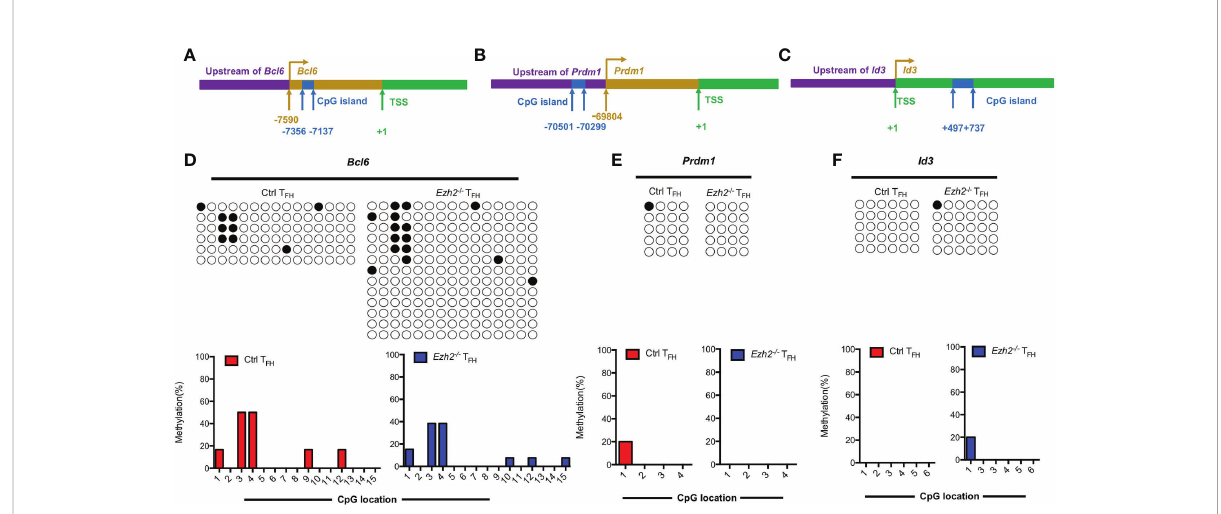
FIGURE 4 EZH2 displays inability to affect the methylation status at other gene loci. Genomic DNA was extracted from sorted T FH cells derived from control and Ezh2 -/- mice at day 8 after LCMV Armstrong strain infection. (A – C) Schematic diagram of CpG island at Bcl6 locus (A) , Prdm1 locus (B) and Id3 locus (C) . (D – F) The DNA methylation status at Bcl6 locus (D) , Prdm1 locus (E) and Id3 locus (F) were performed by bisul fi te sequencing analysis with or without EZH2 ablation. The horizonal lines were corresponding to the colonies selected for sequencing. Filled black circles indicate methylated cytosine, open white circles indicate nonmethylated cytosine.